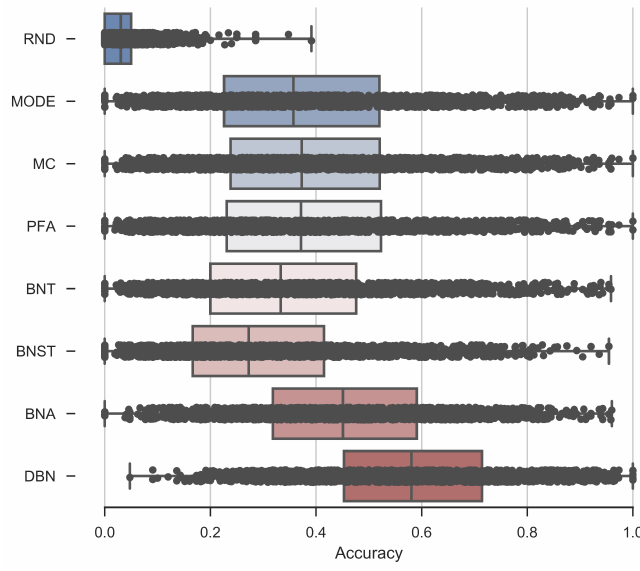
Figure 3. Prediction accuracy of the type of visited